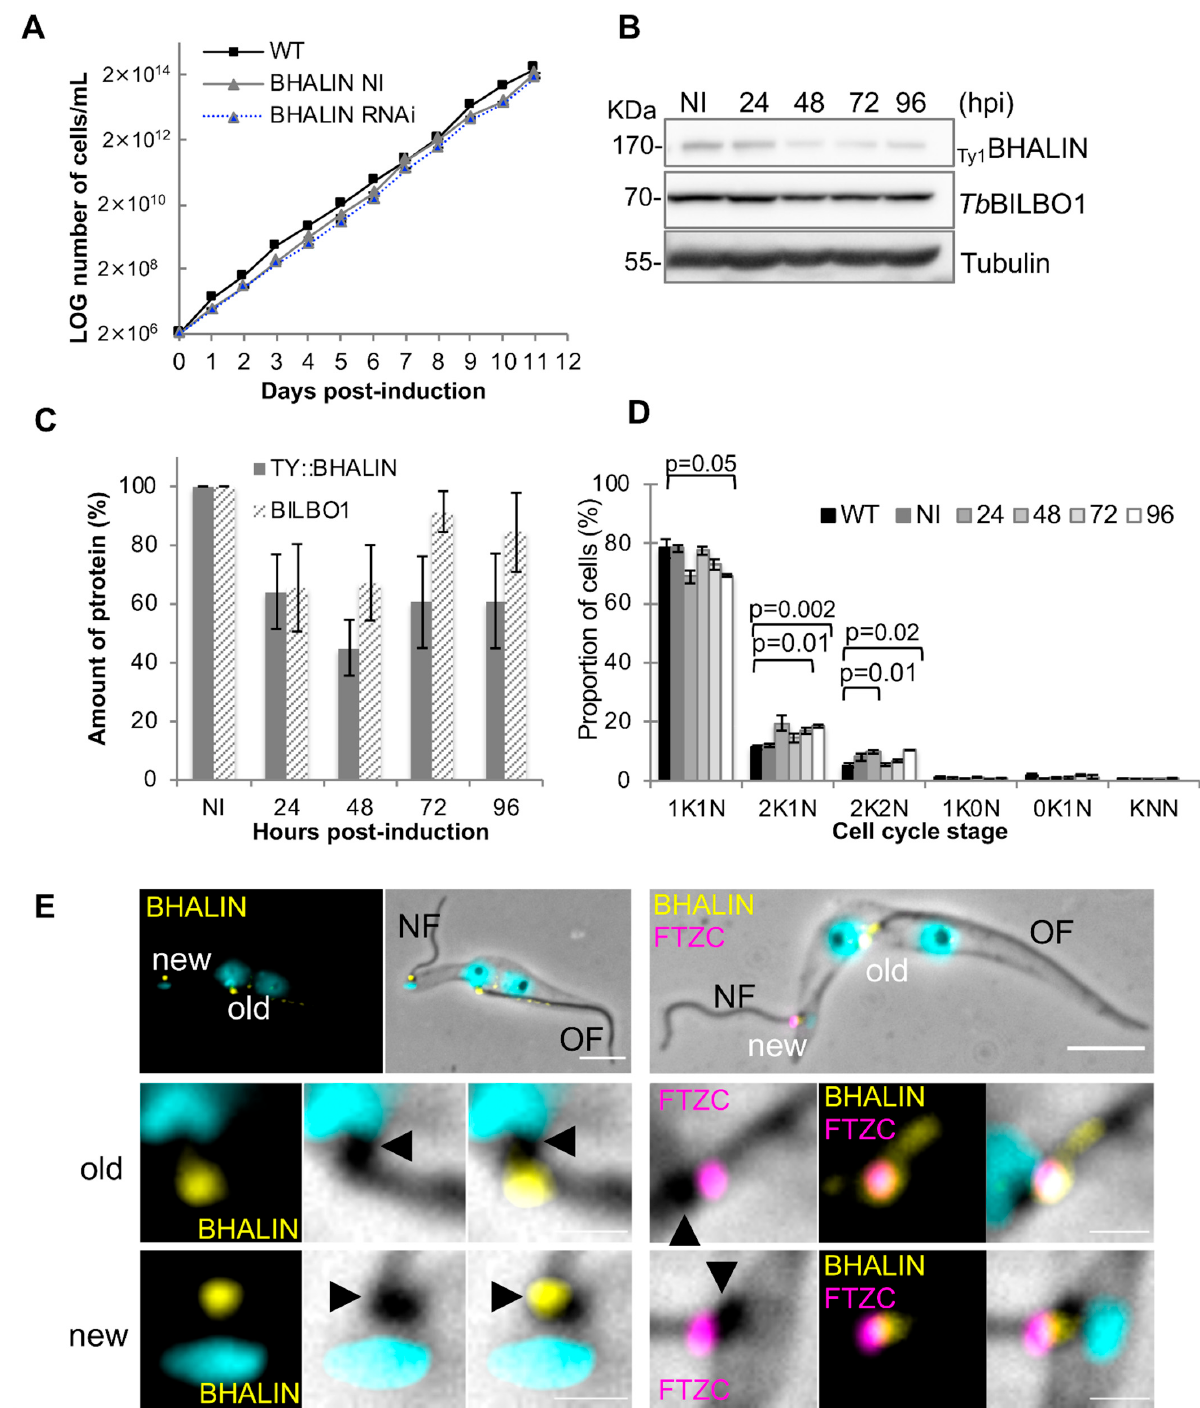
Figure 4. BHALIN plays a minor role in the PCF cell cycle and is associated with the basal bodies in Tb BILBO1 knockdown PCF cells. ( A ) Growth curve of WT PCF, non-induced (NI) and BHALIN RNAi induced trypanosomes. ( B ) Western blot of trypanosomes collected before (NI) and at 24 h intervals post-RNAi induction; tubulin used as a loading control. ( C ) Quantification of Western blots from 3 separate inductions; mean ± SE. ( D ) Bar graph to show distribution of trypanosomes in each cell cycle stage for WT, NI and at 24 h intervals post-induction; mean ± SE (student t-test). ( E ) Detergent-extracted PCF cells induced for Tb BILBO1 RNAi knockdown (24 H) and immunolabelled with chicken anti-BHALIN (yellow) (left panel) or with anti-BHALIN (yellow) and with anti-FTZC a transition zone marker (magenta) (right panel). The black arrowheads indicate the basal bodies. Scale bars = 5 µ m, insets = 1 µ